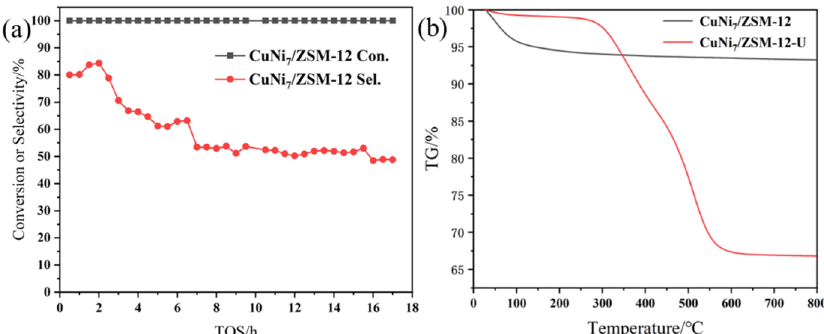
Figure 10. The stability test of CuNi 7 /ZSM-12 catalyst for acetylene semi-hydrogenation to ethylene ( a ). Test conditions: P = 0.1 MPa, T = 250 °C, GHSV = 9000 mL·g − 1 ·h − 1 , and TG results of CuNi 7 /ZSM-12 before and after reaction ( b ).